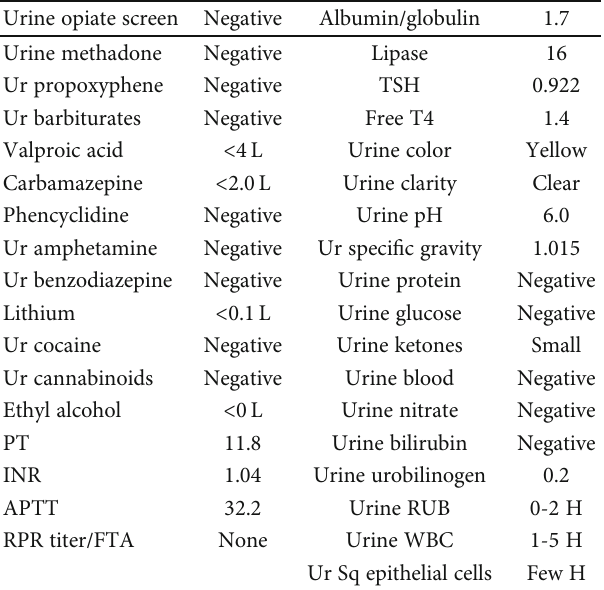
Table 2: Urine toxicology, urine analysis, RPR, and other metabolic pro fi les.